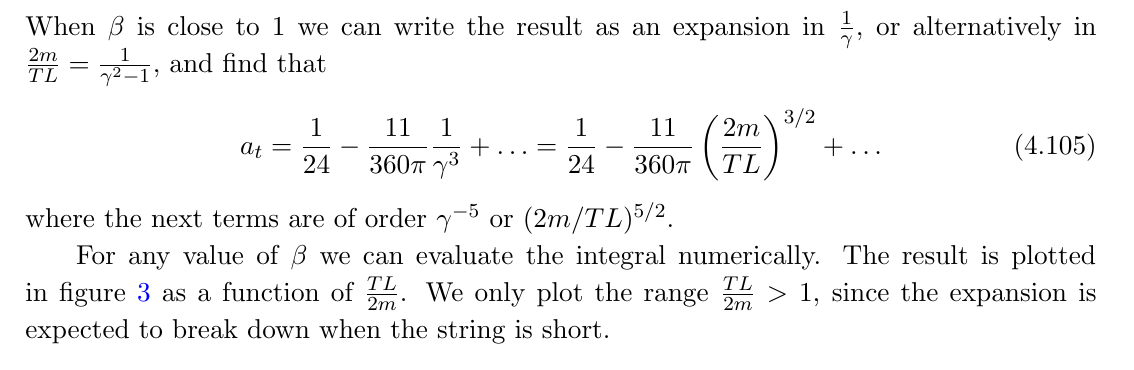
Figure 3 . Left: the intercept of the rotating string as a function of TL intercept is normalized by the value at m ! 0, which is 1 as de(cid:12)ned in eq. (4.94), similarly